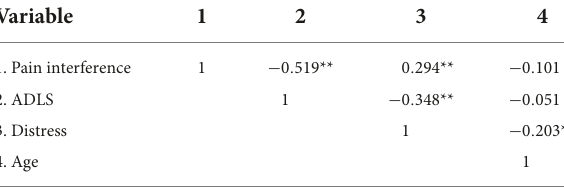
TABLE 4 Correlation matrix for pain interference, distress, ADLs and age, N = 123.